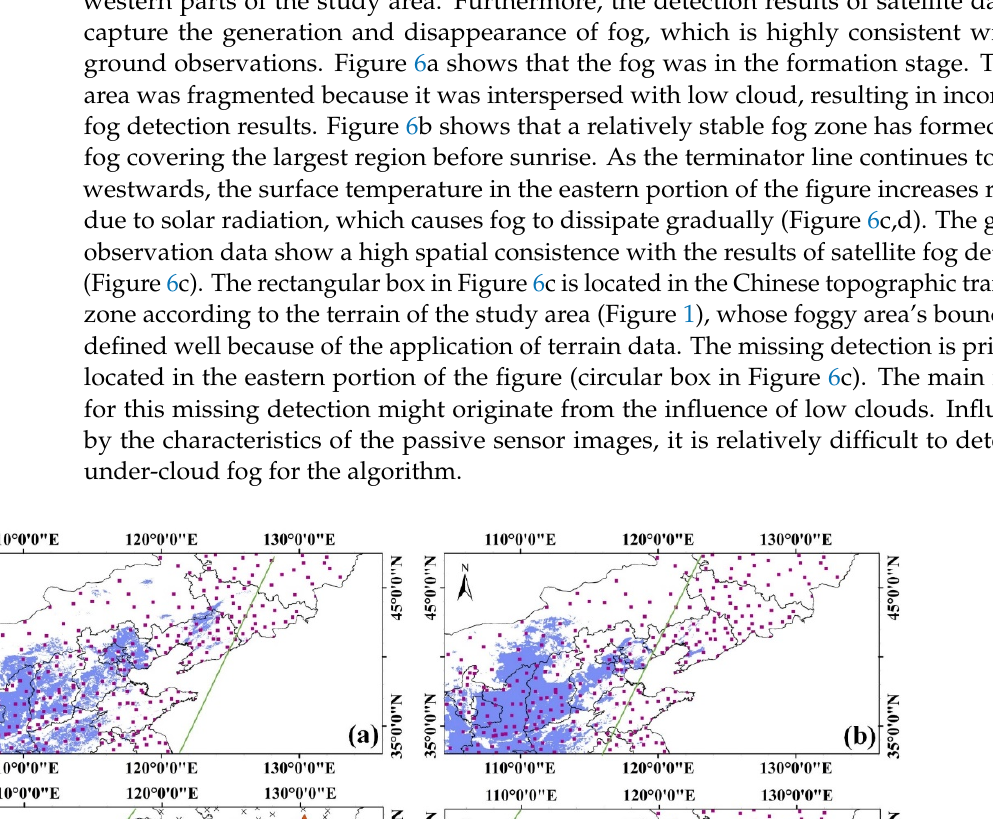
Figure 7. The fog detection results at ( a ) 15:30, ( b ) 16:00, ( c ) 16:30 and ( d ) 17:00 on 18 November 2016. The triangle, star, circle, and cross symbols represent haze, dense fog, strong fog, and non-fog